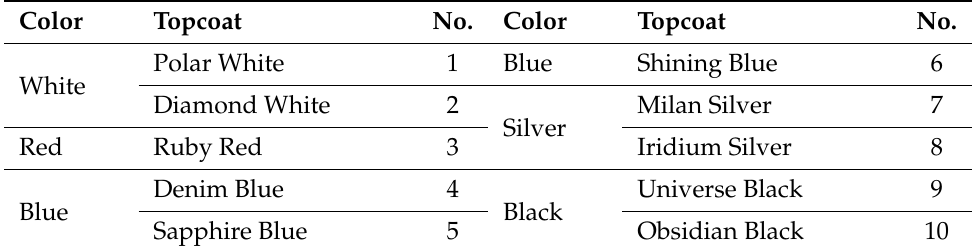
Table 1. All categories of topcoats.